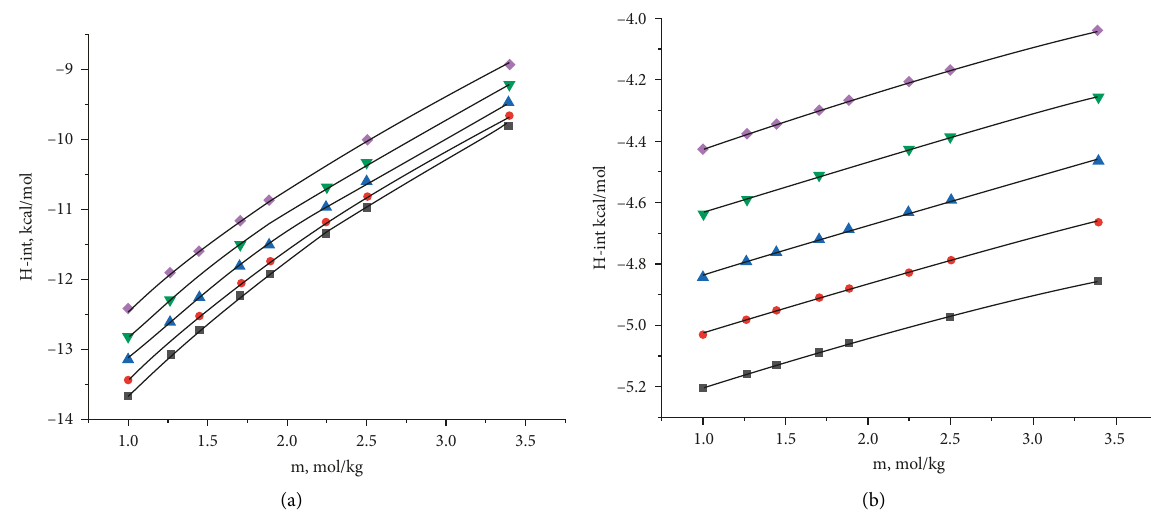
Figure 4: Correlation of the interaction data for the BaBr2+H2O system. (a) The interaction of BaBr2 and (b) the interaction of H2O. Symbols ( , T � 303.15K;